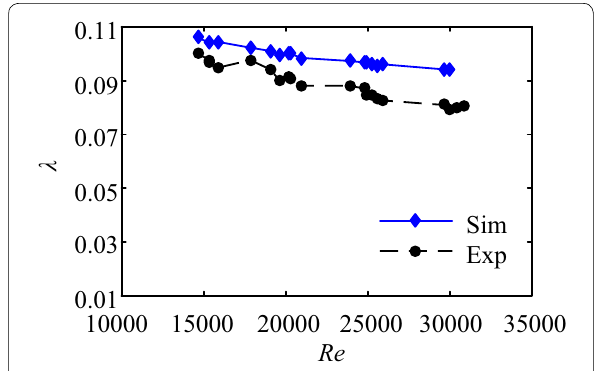
Fig. 3 Comparison between simulation and experimental results of friction factor; Sim represents the simulated results in this work, Exp represents the experimental results in Meng (2003)